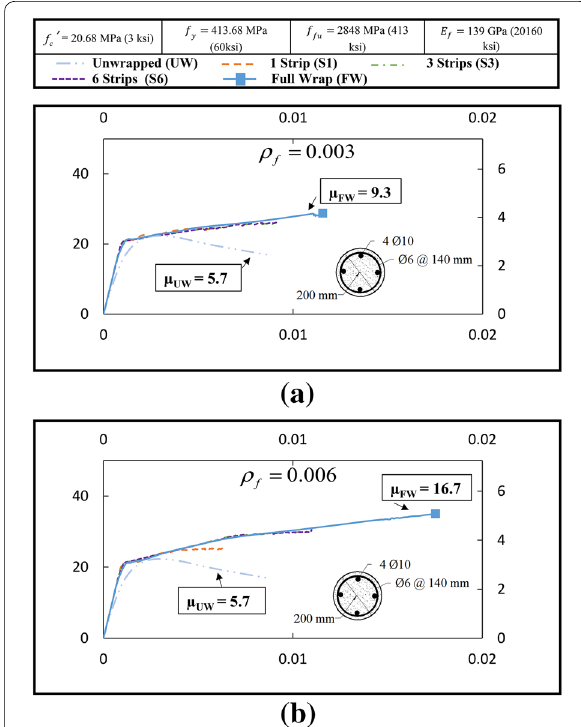
Fig. 5 Comparison of compressive stress ( f c ) versus axial strain (ε c ) for the column with 1-Strip (S1 in Fig. 2) for: a Groups 1–4 and b for Groups 1, 3 and 4 (Table